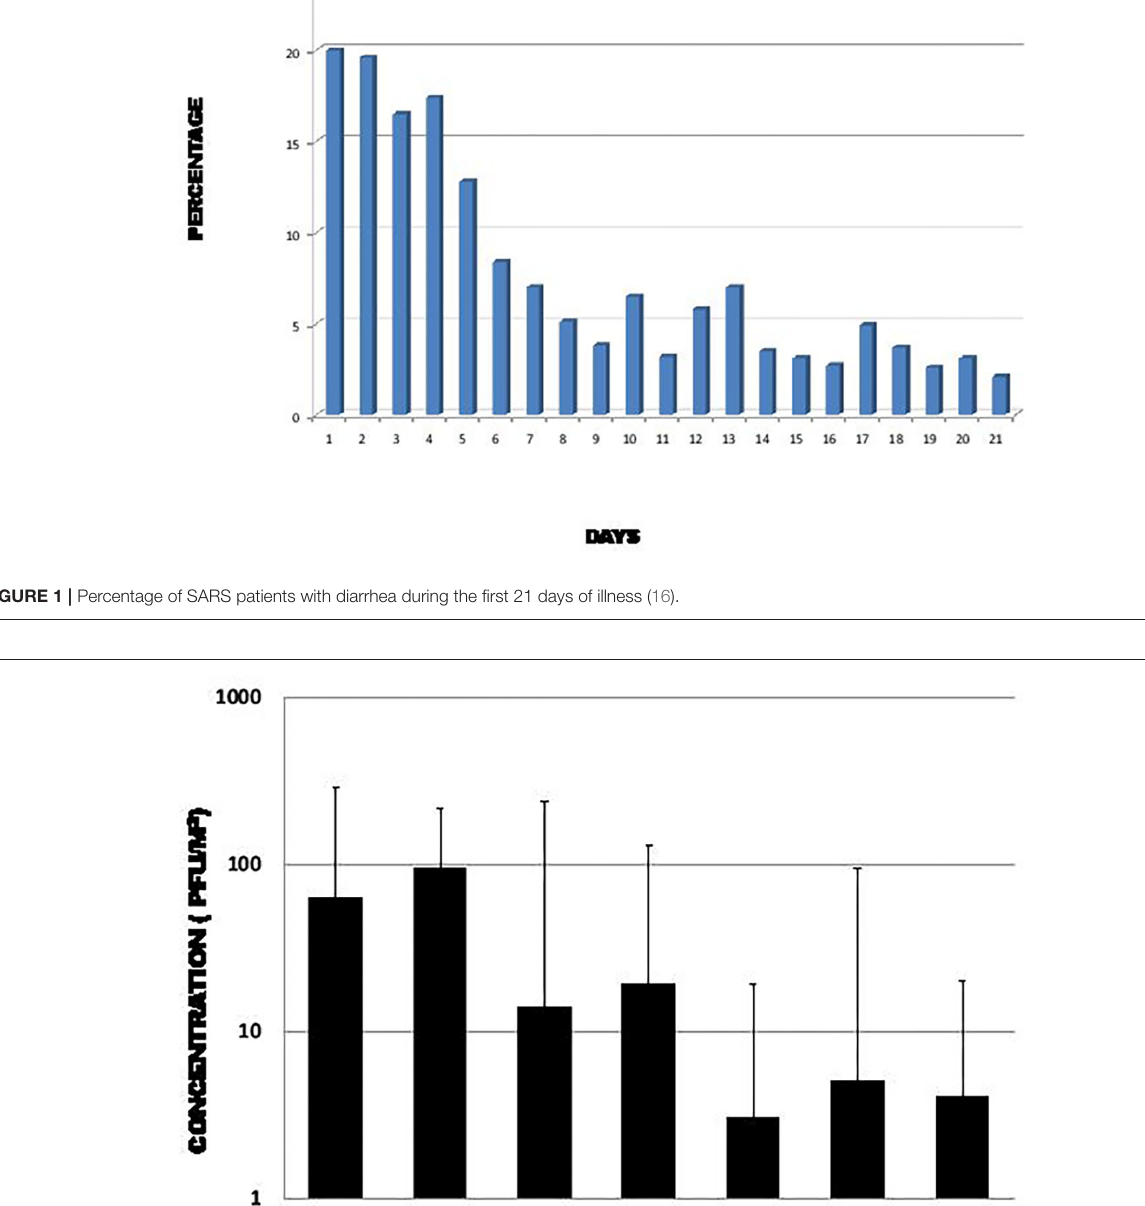
and on surfaces it is deposited on, depending on environmental conditions and the type of surface